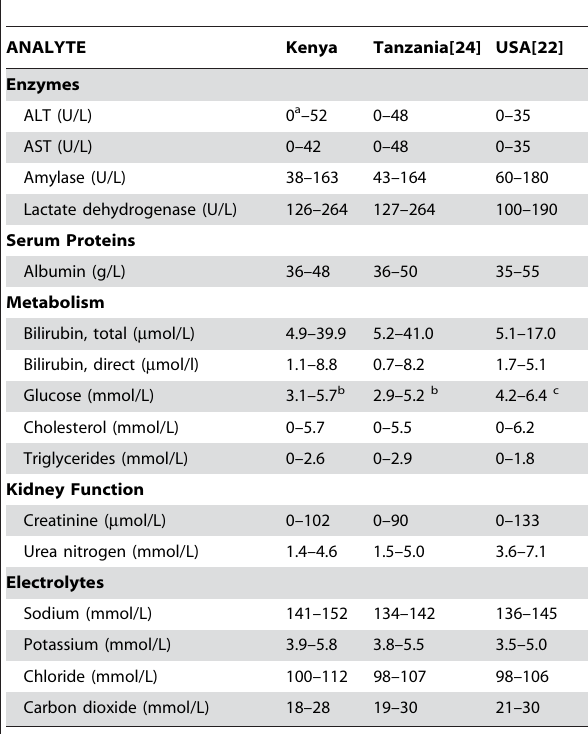
a : 2.5 th percentile set to zero to match comparison ranges, and thus differs from Table 3. b : Non-fasting measurement. c : Fasting